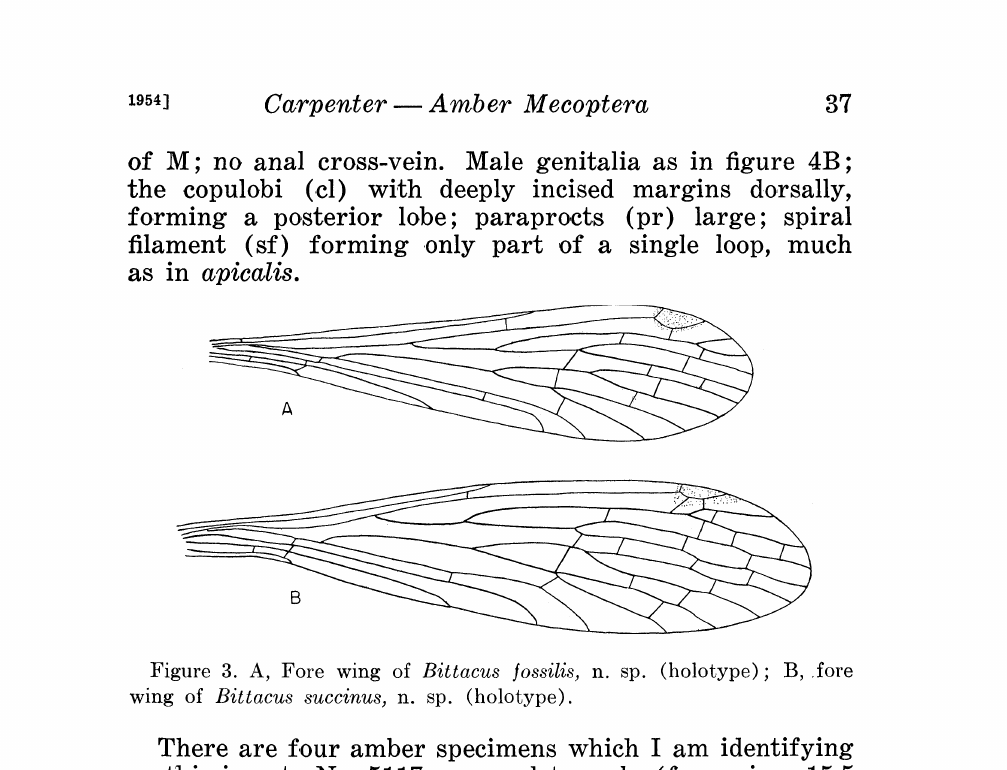
Figure 3. A, Fore wing of Bittacus ]ossilis, n. sp. (holotype); B, .fore wing of Bittacus succinus, n. sp.